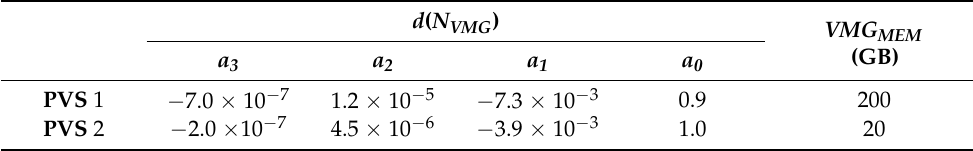
Table 6. Optimal CMP Specifications with KVM